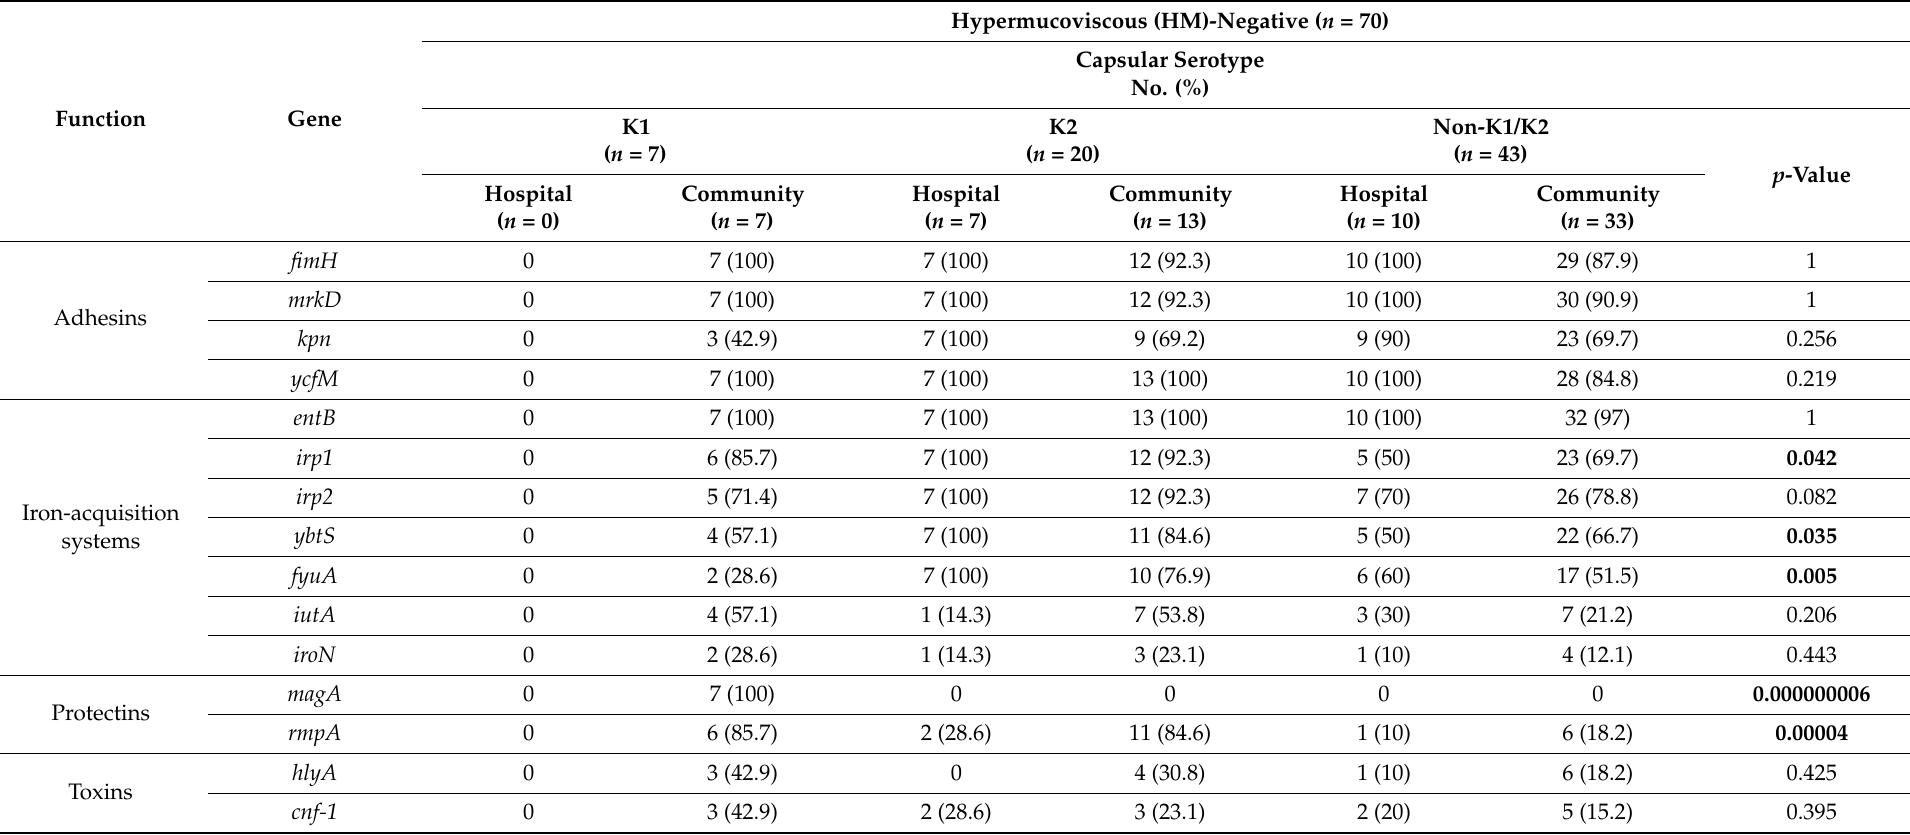
Table 7. Distribution of virulence genes according to hypermucoviscous (HM)-negative strains and capsular serotype of K. pneumoniae isolated from patients with hospital- and community-acquired